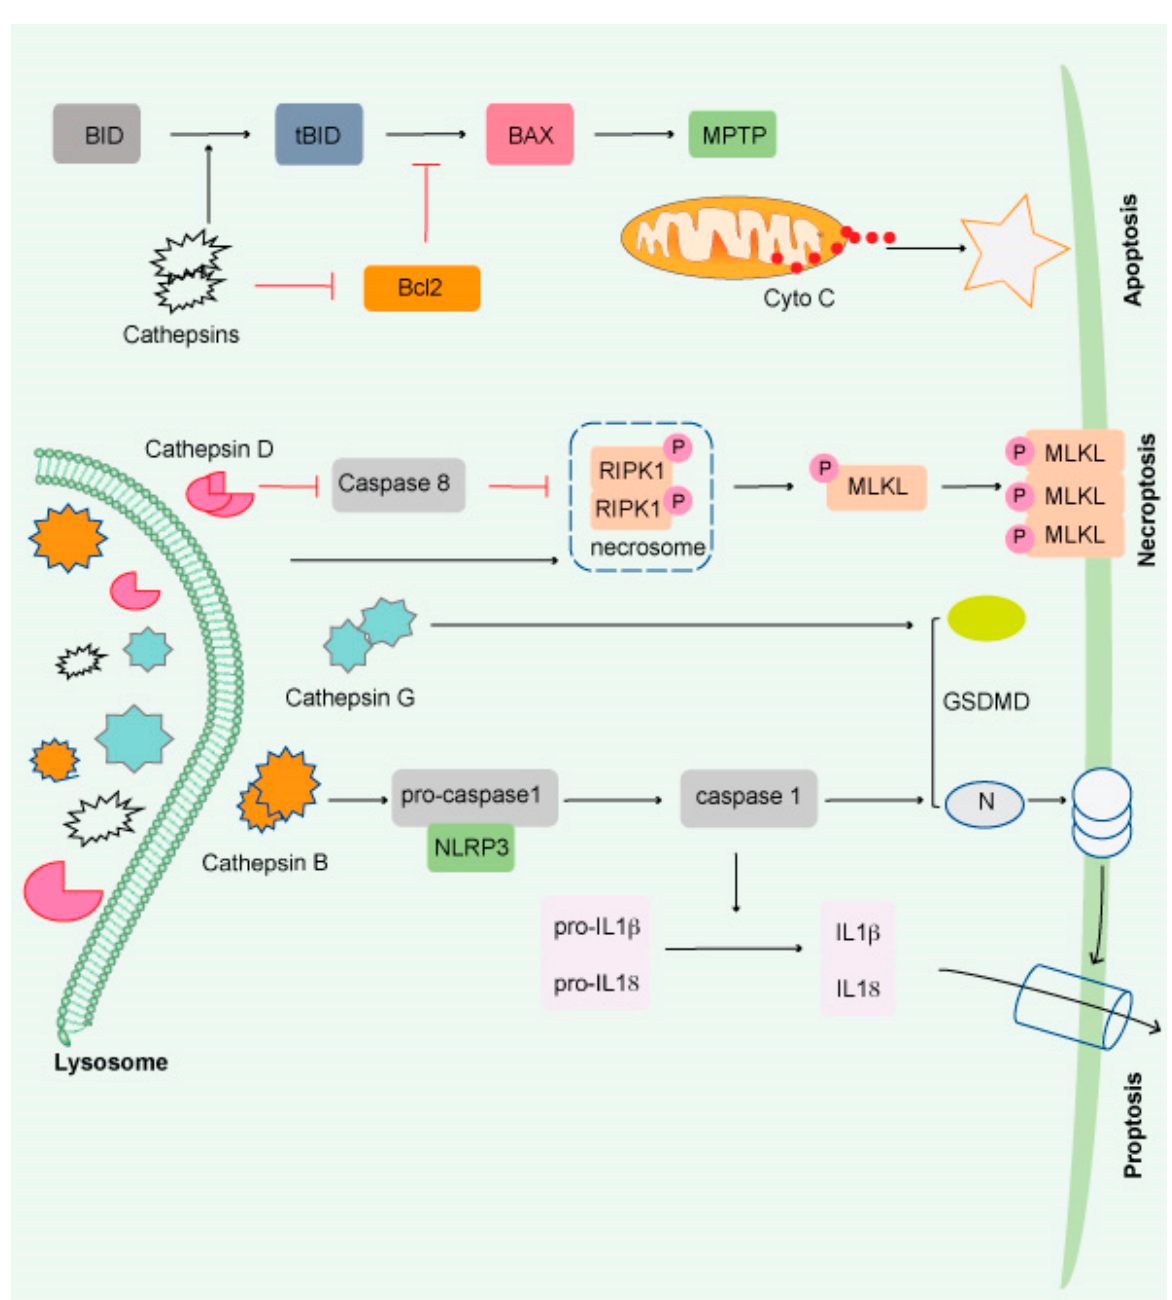
Figure 2. Impairment of the lysosome induces apoptosis. Apoptosis is triggered by lysosomal damage in a mitochondrial-dependent manner. BID is cleaved into tBid by damaged lysosomes, which increases BAX oligomorphism via inducing Bcl-2 degradation by cathepsins. As a result, BAX is translocated to the mitochondrial outer membrane (MOM), where it interacts with mitochondrial permeability y transition pore (MPTP) to release cytochrome C (Cyto C) and triggers apoptosis. Necroptosis occurs when lysosomal activity is inhibited, resulting in the accumulation of necrosome components (such as RIPK1 and RIPK3) and the release of hydrolyzed caspase 8. The necroptosis executor (MLKL) is phosphorylated and translocated to the cell membrane or organelle membrane, resulting in necrosis. Pyroptosis is induced by damaged lysosomes through cleavage of GSDMD into GSDMD-N by releasing CTSG, activation of NLRP3, and caspase-1 by the release of CTSB. Pyroptosis is induced by damaged lysosomes through the cleavage of GSDMD into GSDMD-N by the release of cathepsin G and the activation following that. Pyroptosis results in cell perforation and release of large amounts of interleukin-1 and interleukin-18.